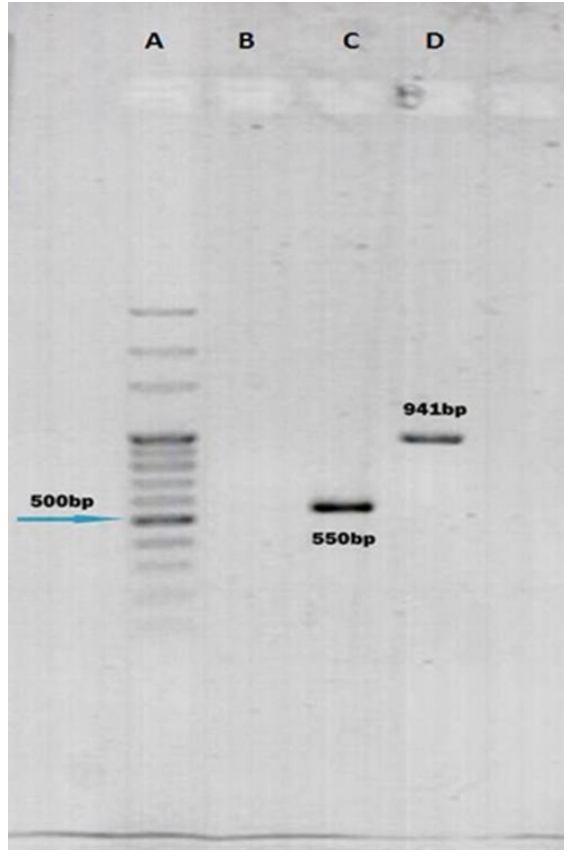
Fig. 1. An example of gel electrophoresis of PCR products used to identify Enterococcus species. Lane A. is marker DNA (100 bp), Lane B. is non-template DNA sample, Lane C. is an amplified (D-Ala D-Ala) E. faecium (550 bp) gene in clinical samples examined, Lane D. is